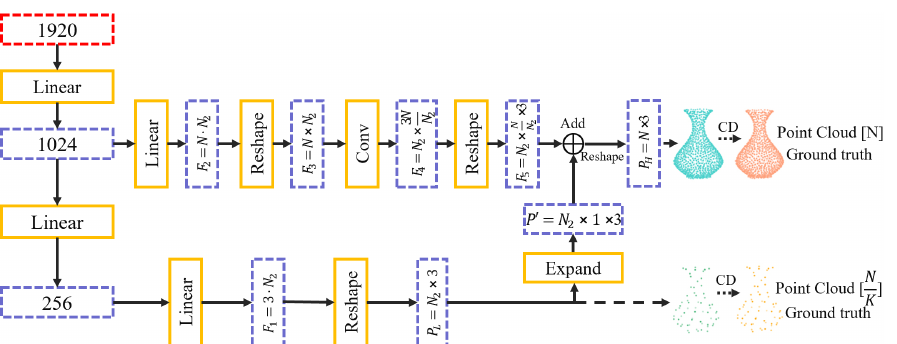
Figure 6. The structure of the decoder in the GN-GAN generator. The decoder uses reshape, Conv layer, and FC layer to output two point clouds with the same resolutions as